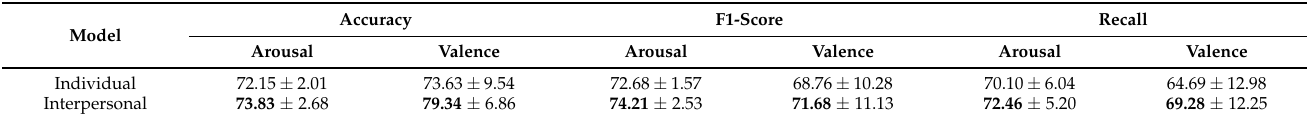
Table 3. The main experiment result for visual